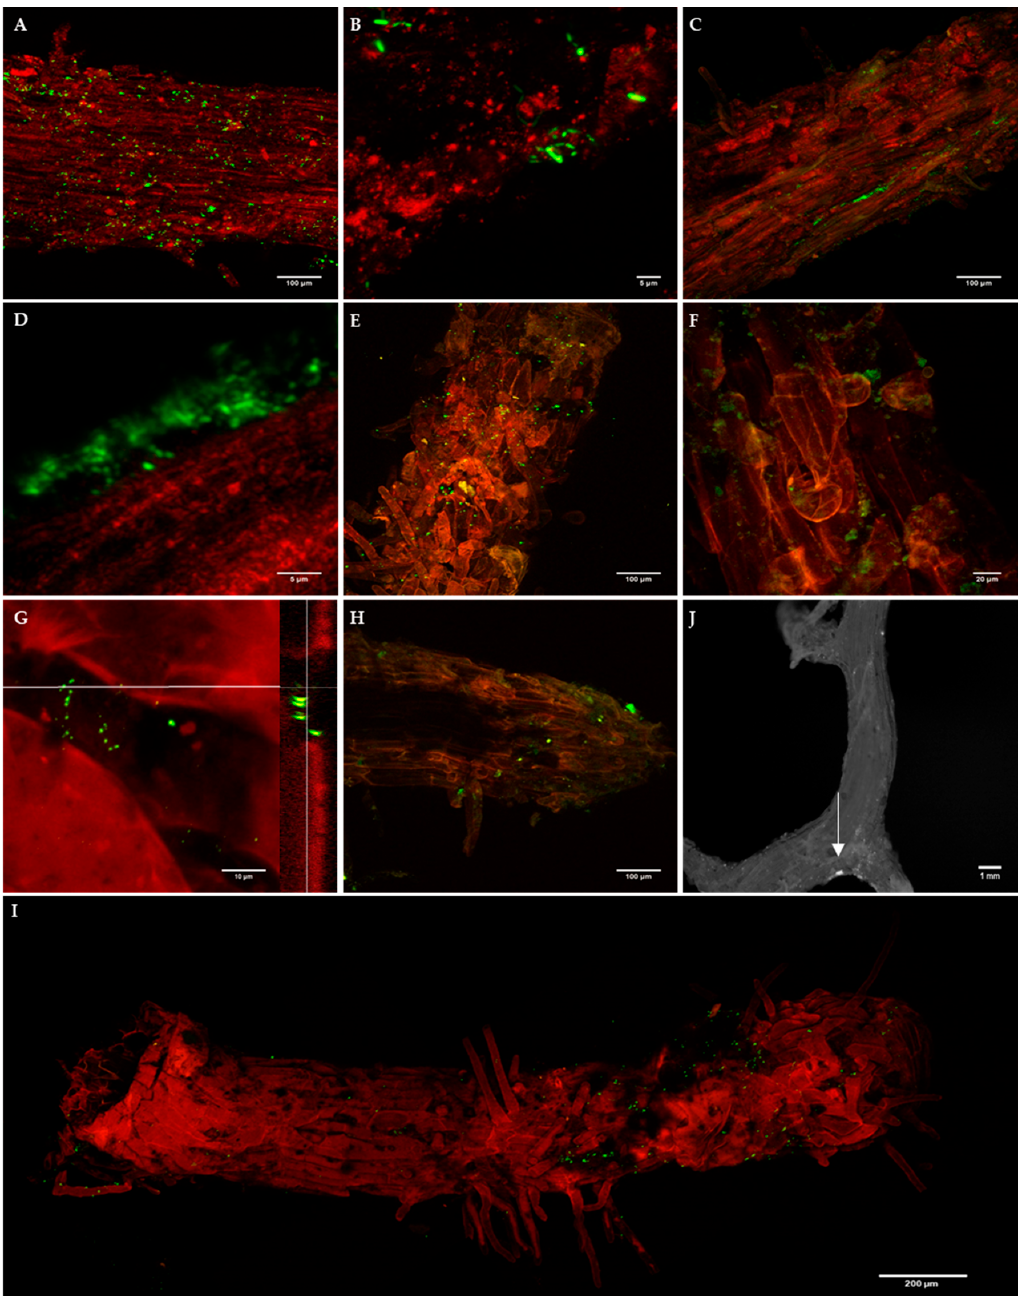
Figure 3. Confocal images of B. simplex /pNF8 ( A , B , E , G , J ) and E. billingiae /pNmI ( C , D , F , H ) on Pinus radiata root epidermis at 1 days after inoculation (DAI) (A–D), 9 DAI ( E , F ) and 24 DAI ( G , H , J ). Epifluorescence image of B. simplex /pNF8 31 DAI ( I ); the white arrow points a bacterial cluster. G: Confocal image of B. simplex /pNF8 cluster and its orthogonal view at 24 DAI. Bacteria, green fluorescence; plant tissue, red autofluorescence to provide anatomical context. At 1 DAI B. simplex /pNF8 were found on the surface of primary and secondary roots forming small clusters or individually ( A , B ) without showing preferences for any root areas, after 9 DAI their presence was concentrated at areas abundant in root hairs ( E , I ) and at the base of emerging lateral roots ( J ). High density clusters of E. billingiae /pNmI appeared from 1 DAI ( C , D , F , H ) which also were present at root tips at 24 DAI ( H ). From 1 DAI presence of E. billingiae was also detected on root hairs ( C , H ).